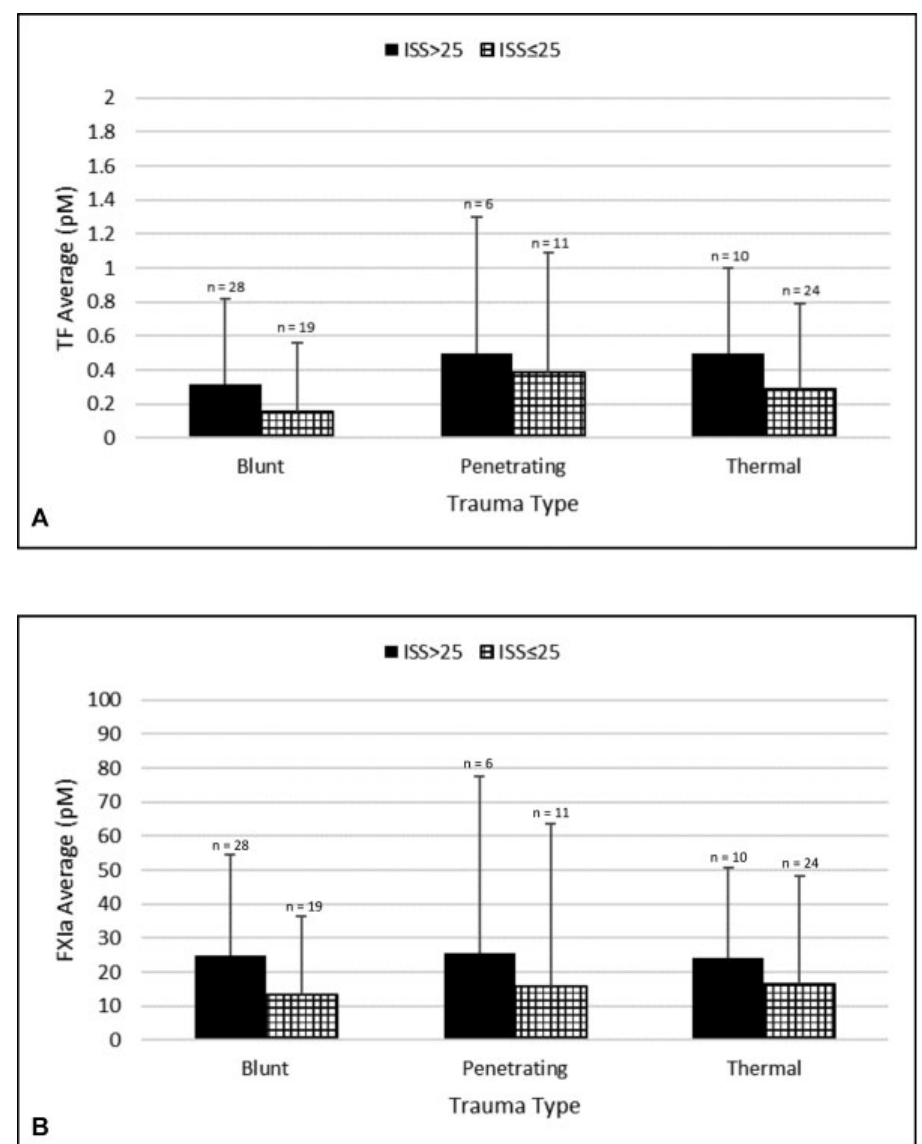
Fig.3 TFand FXIalevelsversusISS. Meanvalues of functional tissuefactor(TF) (A) andactivefactorXIa (FXIa) (B) in plasma from trauma patients at Day 0 for subgroups with an Injury Severity Score (ISS) > 25 and ISS (cid:1)